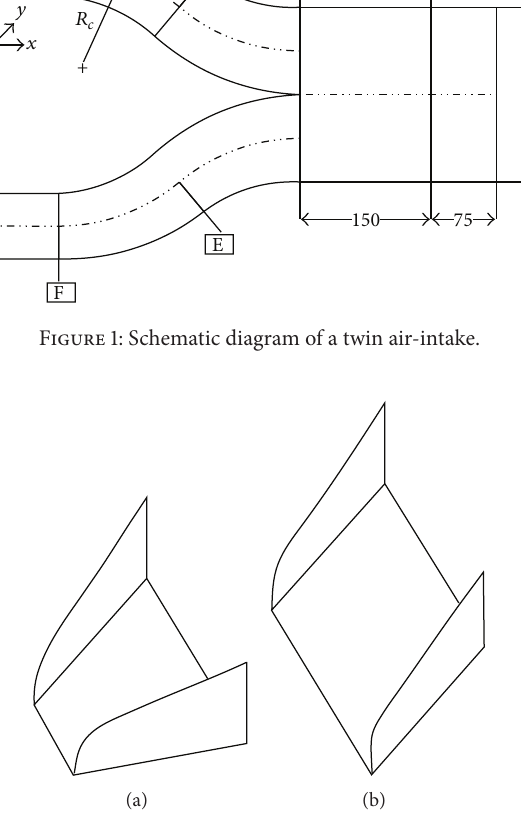
Figure 2: Vane-type vortex generators: (a) counter- and (b) corotat- ing.